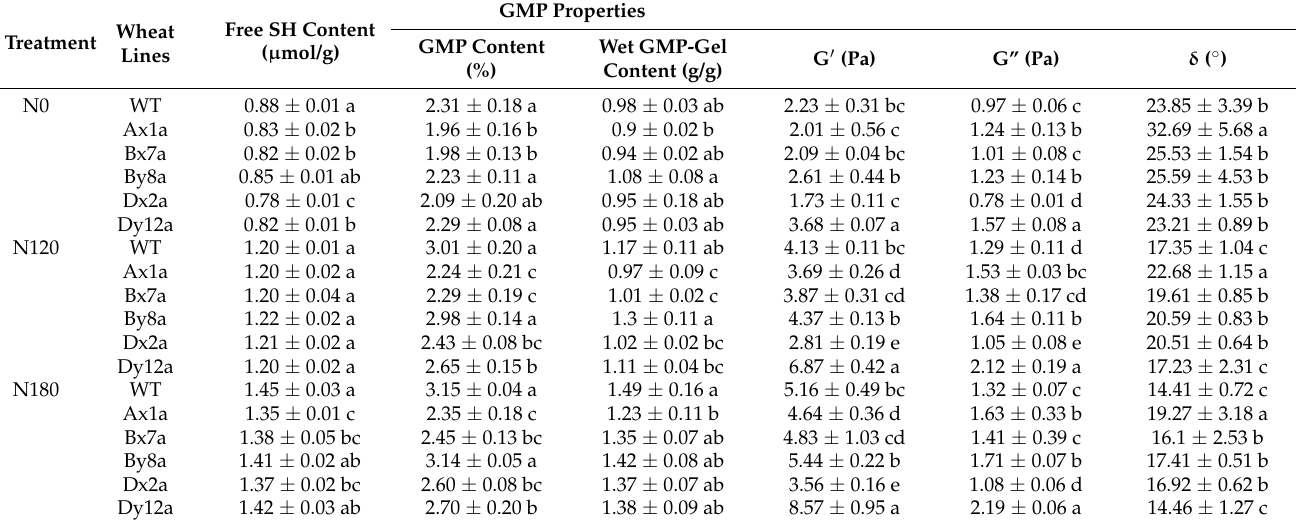
Table 2. Content of free sulfhydryl group (SH) and GMP, rheological characteristics of GMP gels in wheat lines with the absence of HMW-GS under different N treatments in 2017–2018 wheat growing